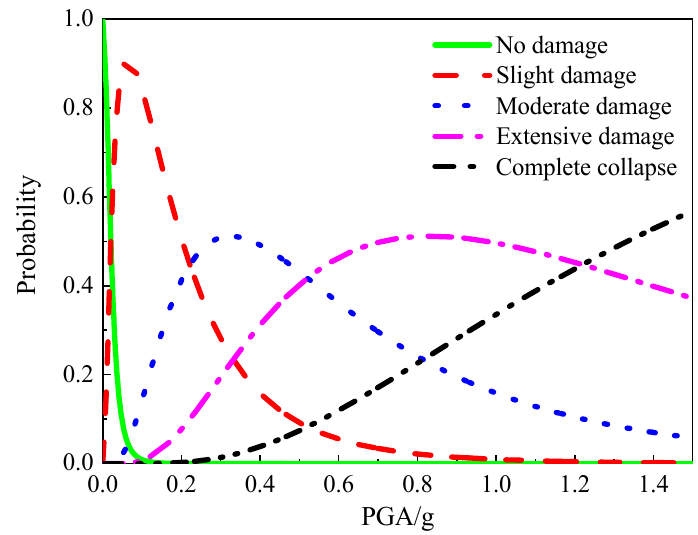
Figure 11. Occurrence probability curves.